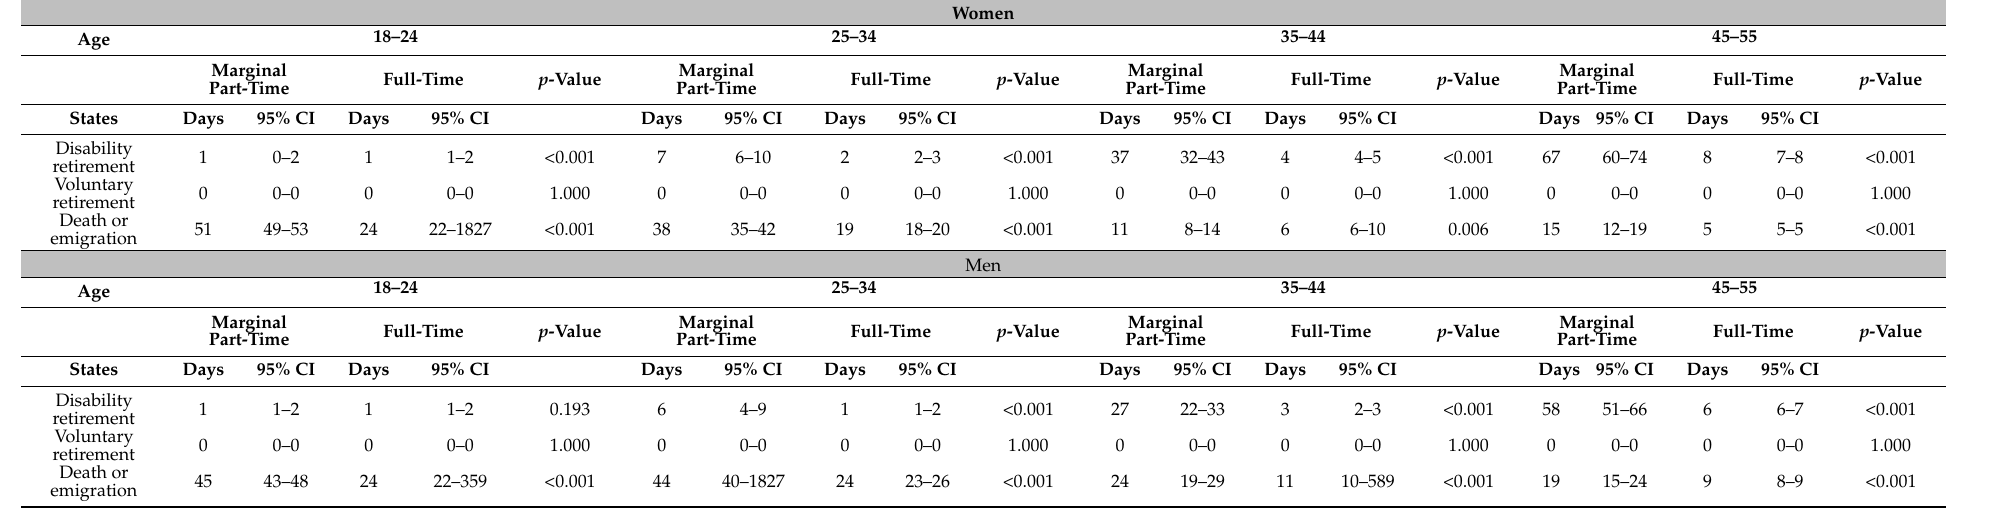
Table A2. Numbers of days in different labor market states during the five years of follow-up by gender and age